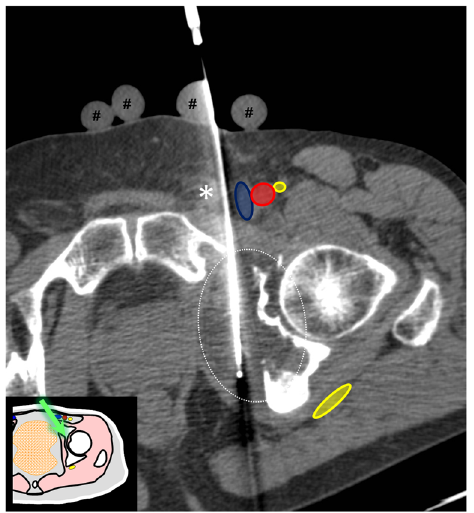
Fig. 22 A 68-year-old man with bladder cancer presenting with painful acetabular metastasis. Axial CT shows one of the cryoablation probes inserted in the lesion with an approach between the spermatic cord ( asterisk ) and the femoral vein. The hypodense ice ball ( dotted line ) is seen. Note the glove fingers filled with warm saline over the skin to prevent thermal skin damage